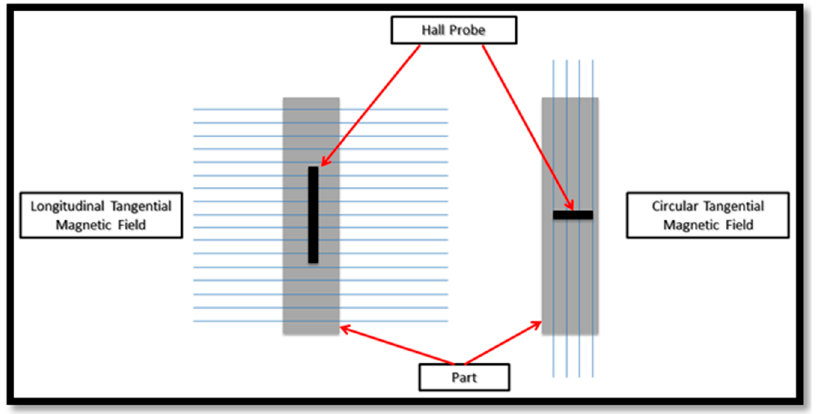
Figure 3. Hall probe positioning for magnetic field measurement.